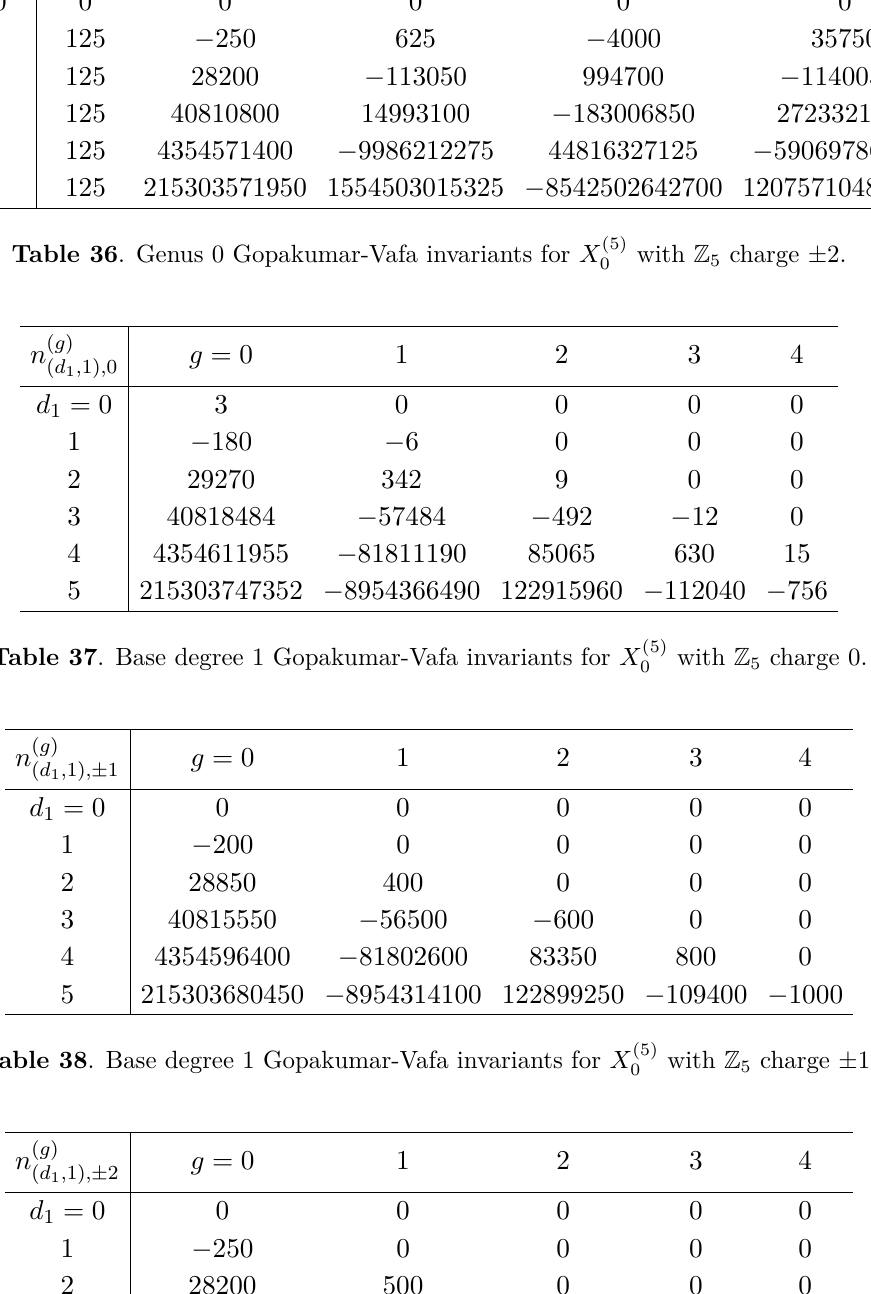
Table 39 . Base degree 1 Gopakumar-Vafa invariants for X (5)